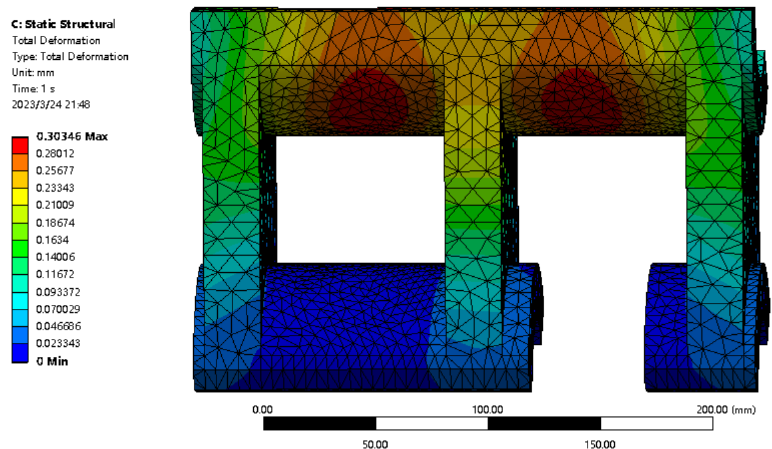
Figure 10. Deformation of hollow drive rod.